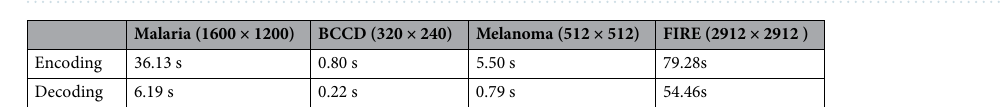
Figure 8. The procedure of Encoder about RGB image with soft compression algorithm for multi-component image.